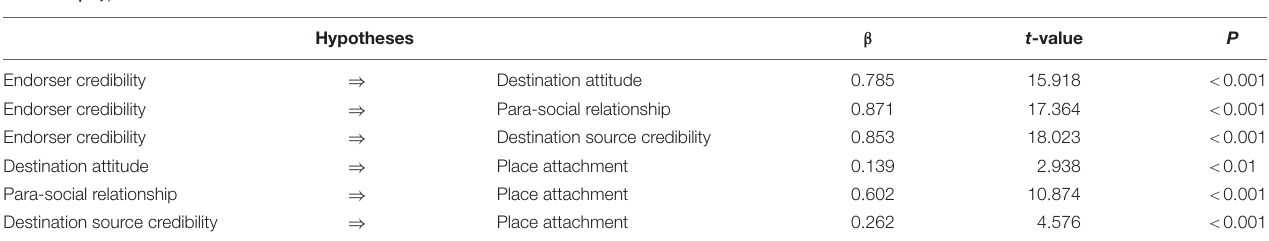
TABLE 4 | Hypotheses